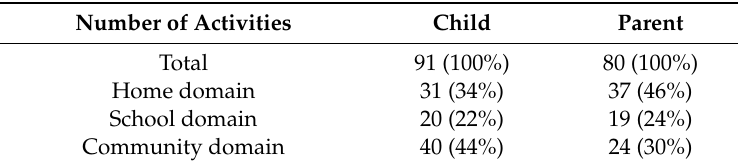
Table 4. Comparison of the desire-to-change activities of children selected by the children ( n = 30) and parents ( n = 28) a . Number of Activities Child Parent Total 91 (100%) 80 (100%) Home domain 31 (34%) School domain